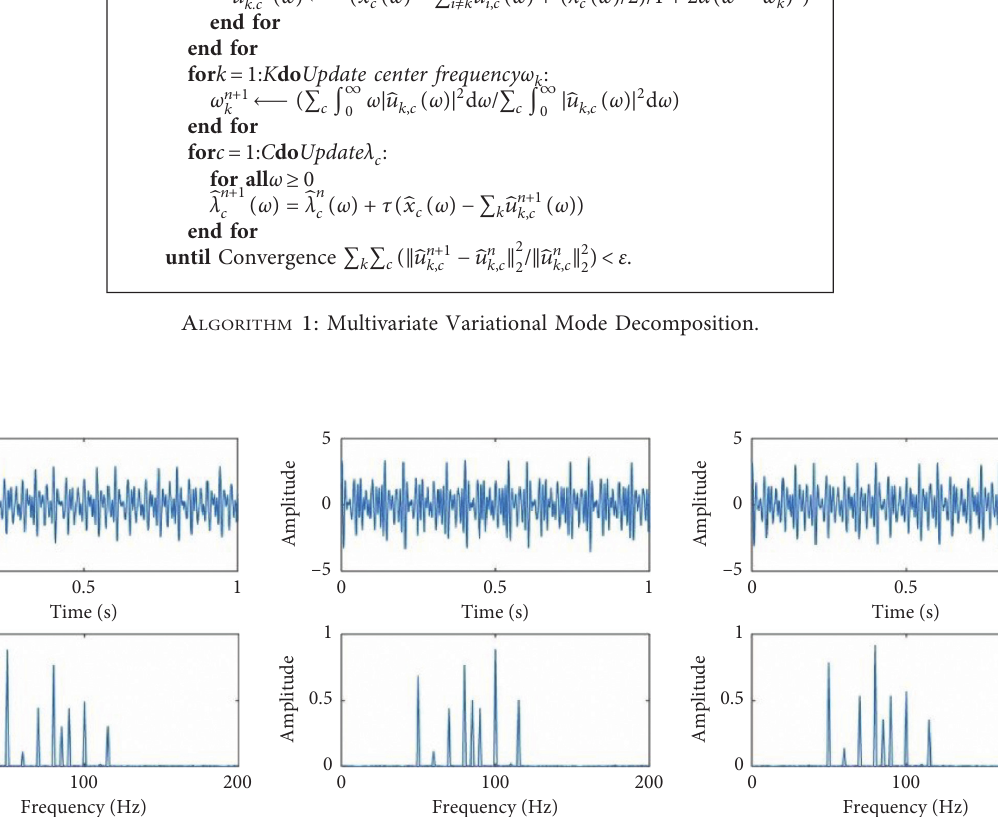
1 . (b) Simulation signal s 2 .